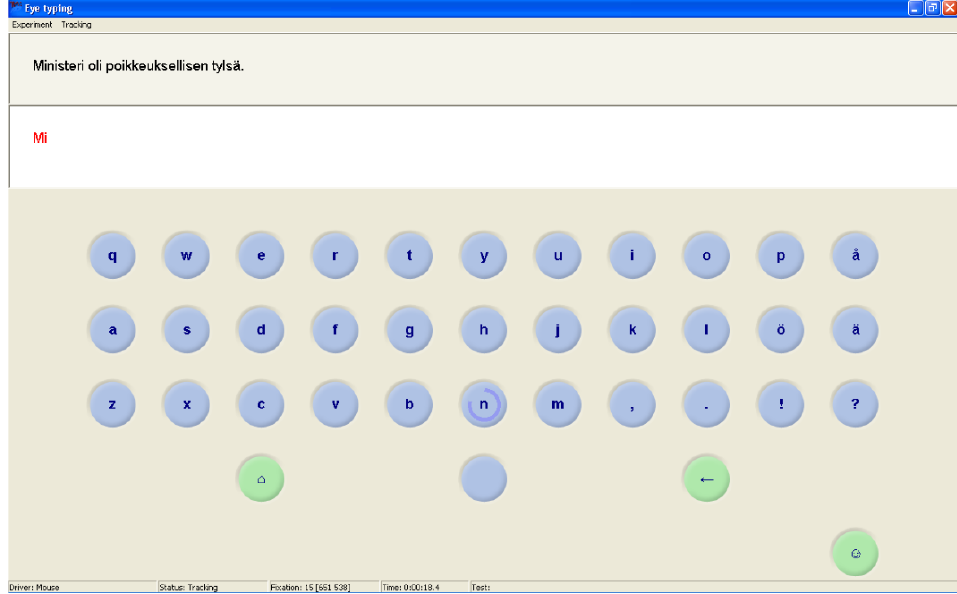
Figure 1. AltTyping virtual keyboard for eye